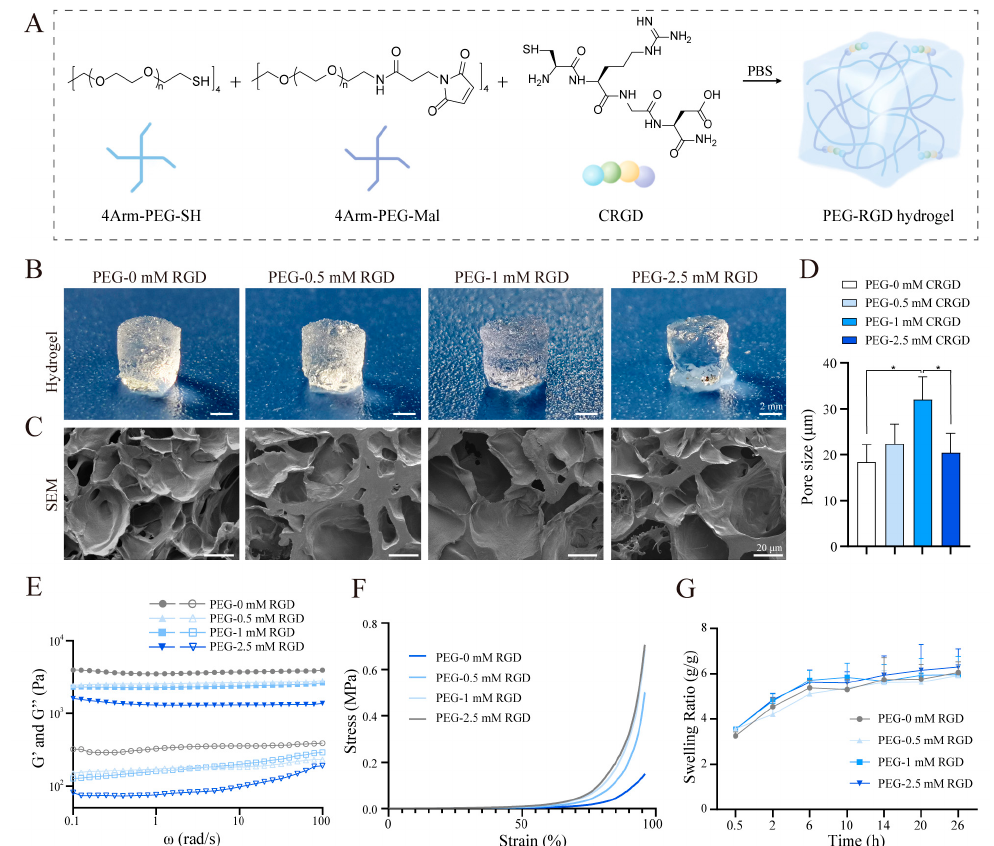
Figure 1. Illustration of PBMSCs in PEG-CRGD hydrogels.